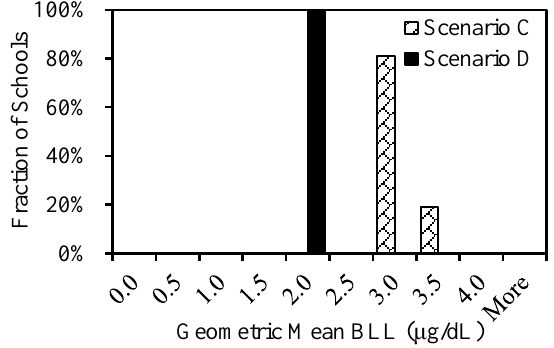
Figure 4. Distribution of BLL geometric means for secondary schools.